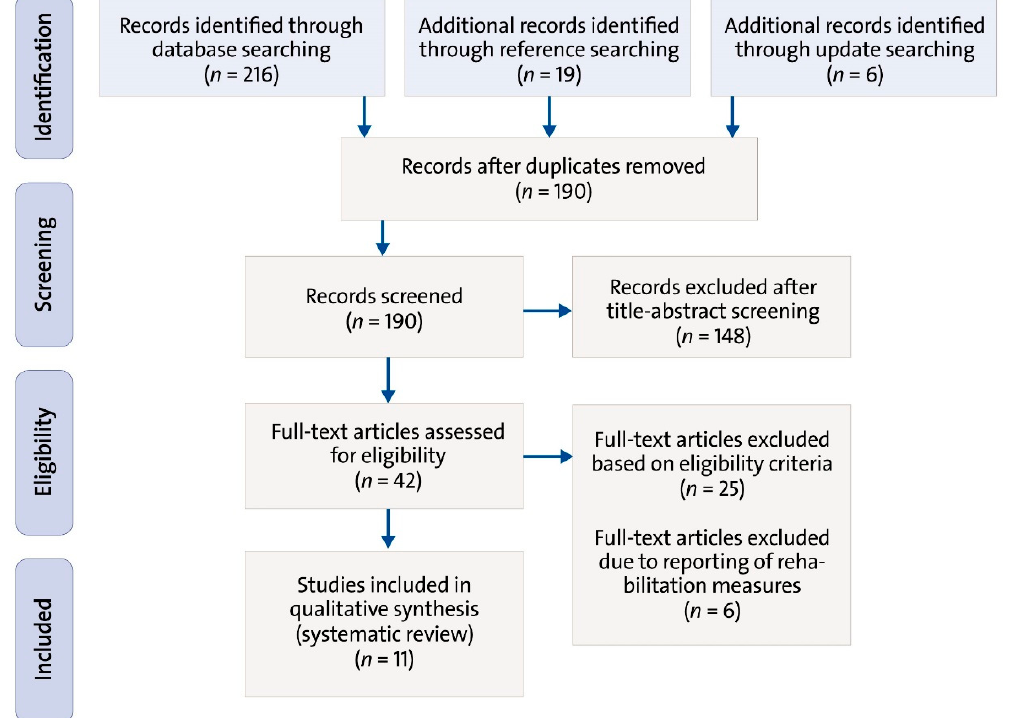
Figure 1. Study selection process for this systematic review (Preferred Reporting Items for Systematic Reviews and Meta-Analyses (PRISMA) Flowchart).